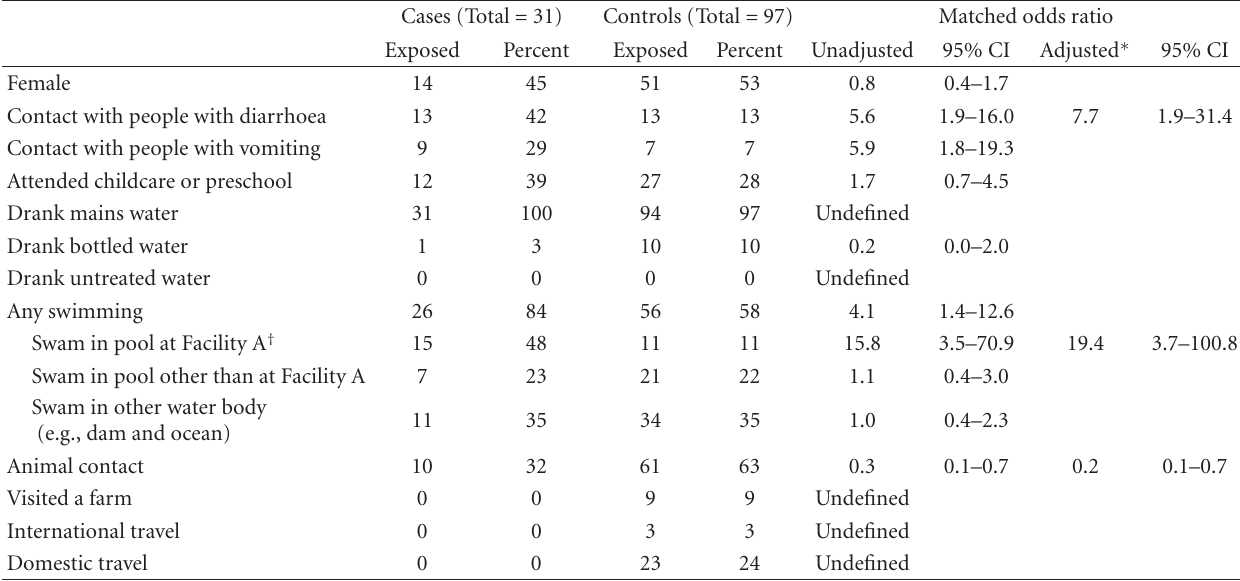
Table 1: Unadjusted and adjusted matched odds ratios for risk factors associated with Cryptosporidium